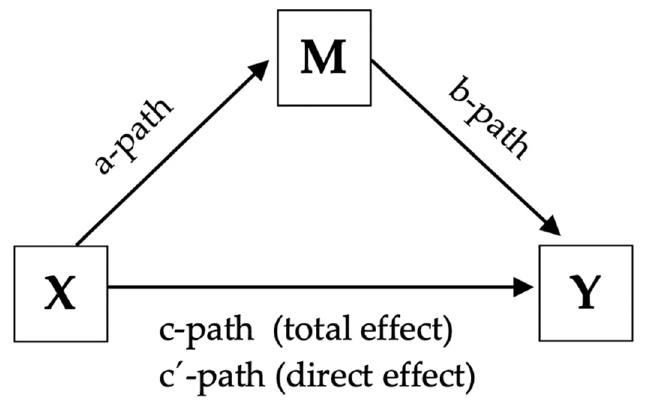
Figure 1. A conceptual diagram of a simple mediation model.